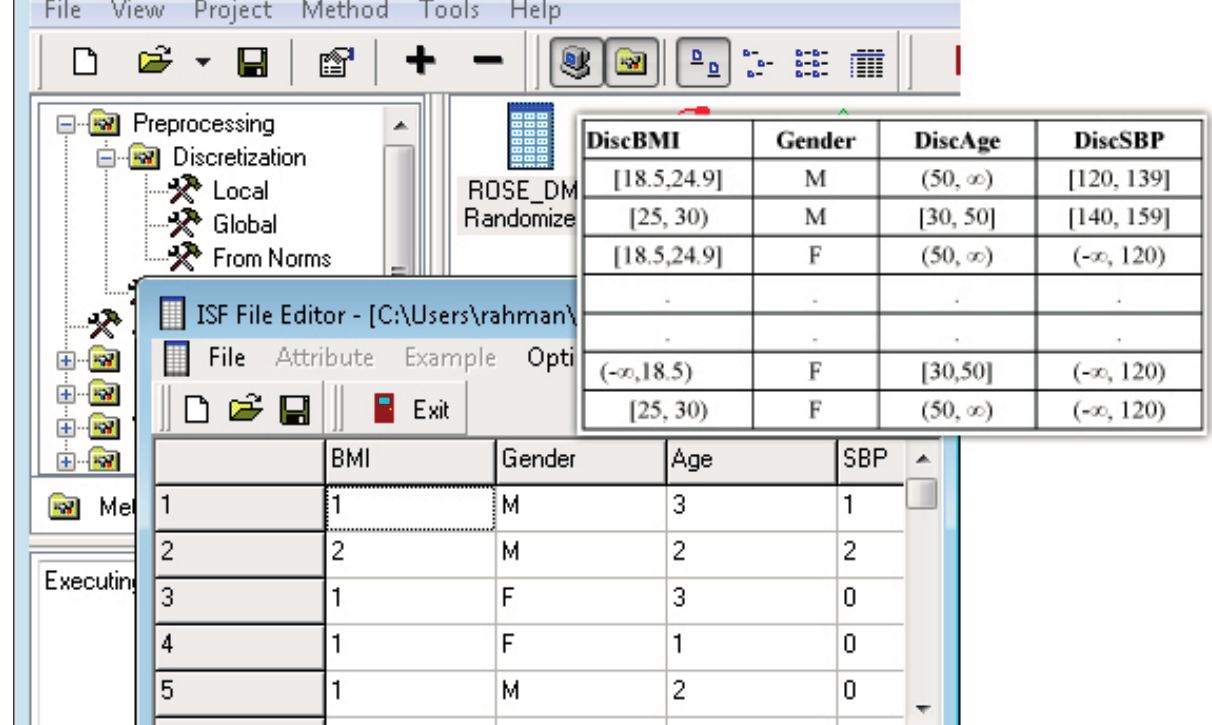
Figure A1. Final discretized results of the diabetes mellitus